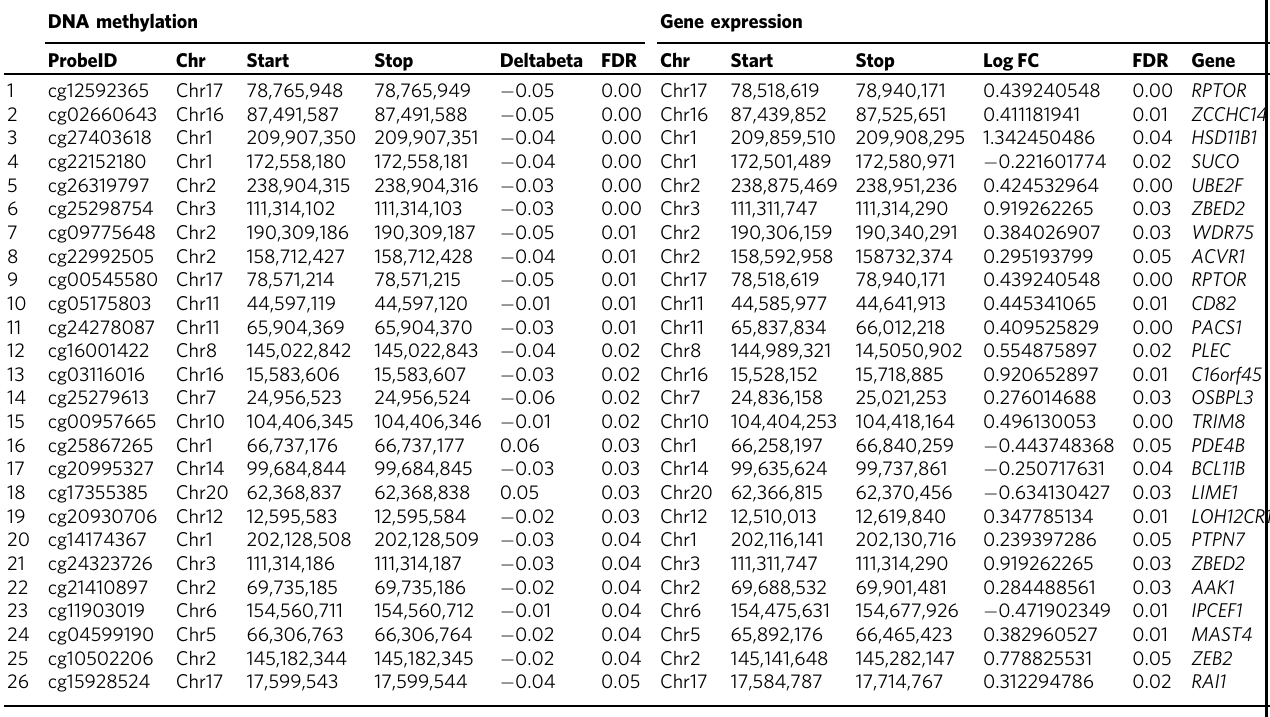
Table 3 Differentially remodeled genes associated with food allergy at 12 months DNA methylation Gene